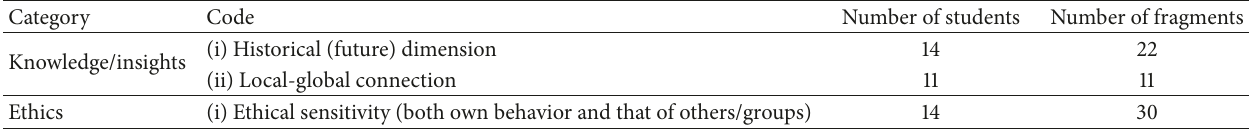
Table 8: Overview of codes assigned for each category SQ2, 𝑁 = 24